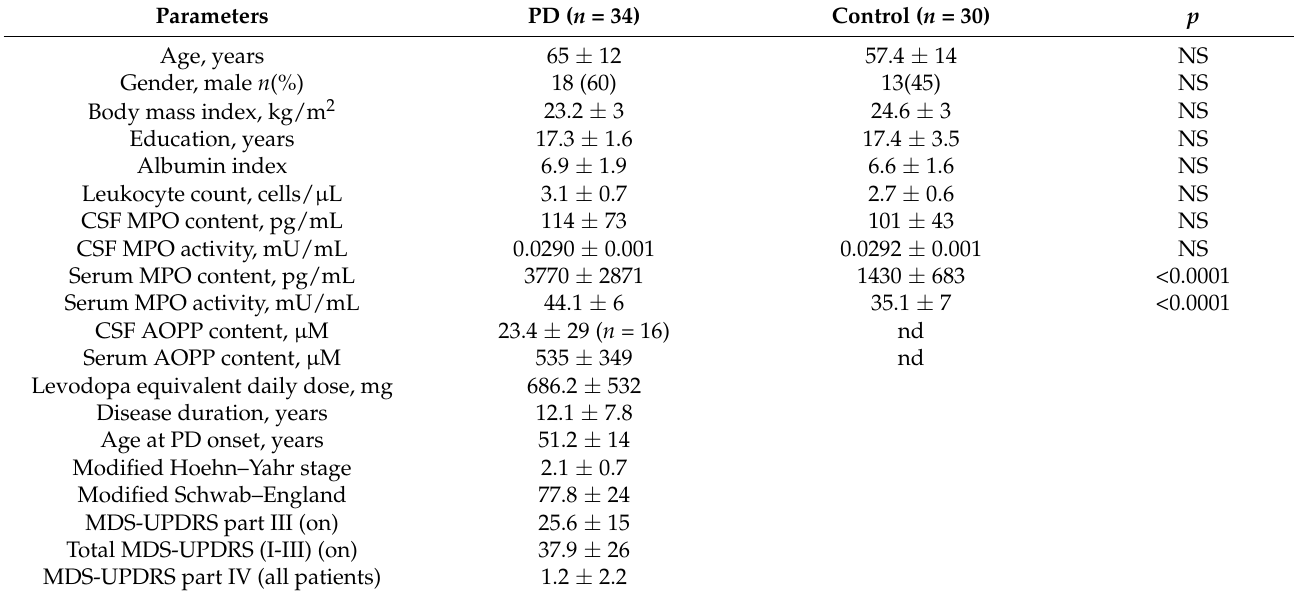
Table 1. Demographic and clinical parameters in the cerebrospinal fluid and serum in the cohort of patients with PD and control